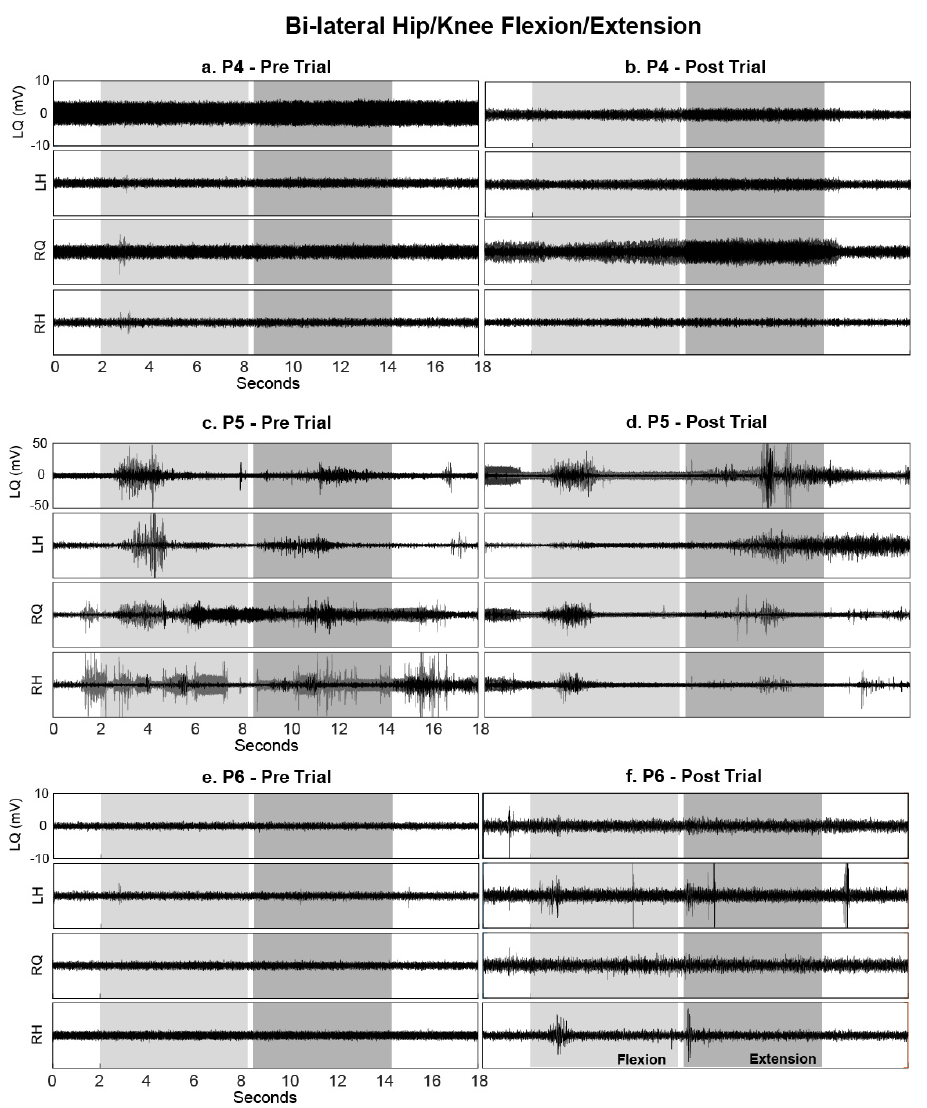
Figure 5. EMG activity recorded from the left (L) and right (R) quadriceps (Q) and hamstrings (H) during hip/knee flexion (light grey) and extension (dark grey) movements without tSCS, before and after the intervention. Data are shown for ( a , b ) P4, ( c , d ) P5 and ( e , f ) P6 (all in the STIM group); each movement was repeated three times, and EMG data from all three movements are